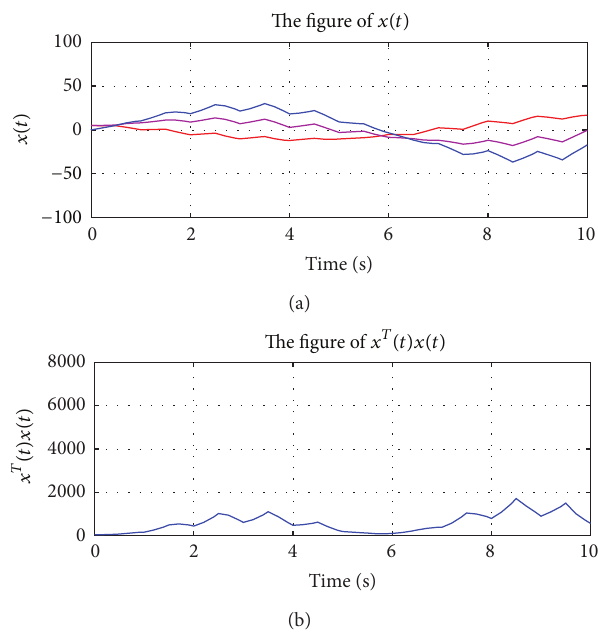
Figure 1: The diagram of switching law.